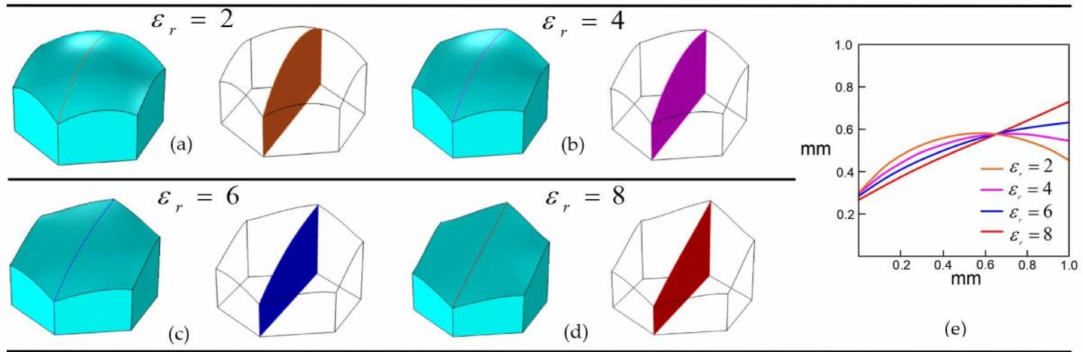
Figure 16. Change in the liquid-liquid interface shape and longitudinal corner plane interface with an increasing dielectric constant, ( a ) ε r = 2, ( b ) ε r = 4, ( c ) ε r = 6, ( d ) ε r = 8, and ( e ) longitudinal corner plane liquid-liquid interface profiles for di ff erent dielectric constants using the three-dimensional simulation.